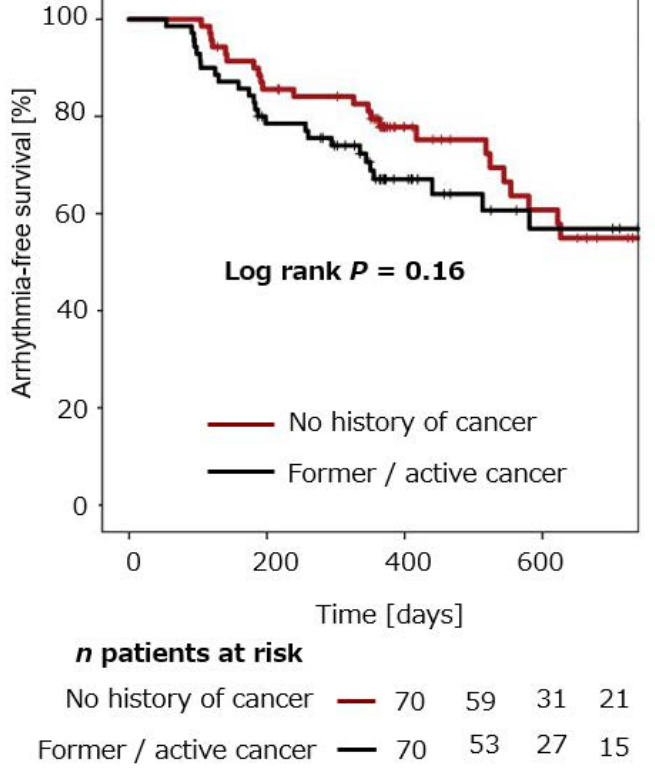
Figure 1. Cumulative freedom from arrhythmia recurrence in patients with and without a history of cancer after